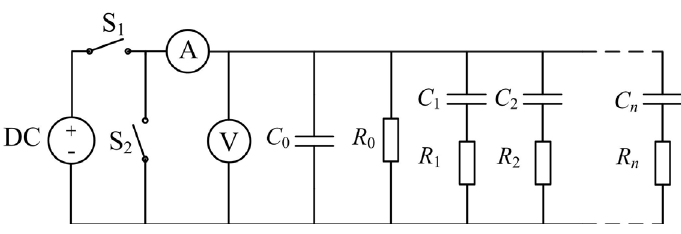
Figure 9. The scheme of return voltage measurement (RVM) test.